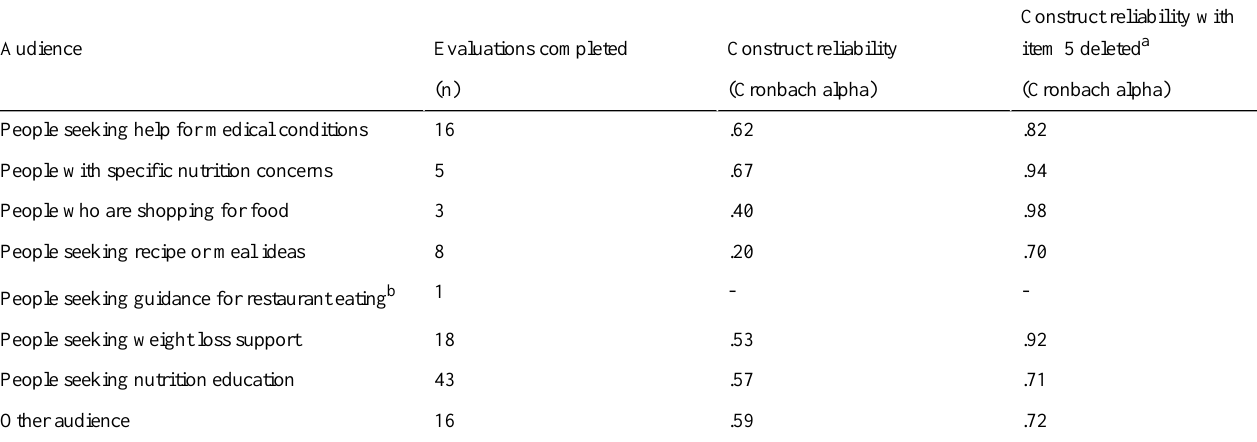
Table 6. Construct reliability of items assessing app appropriateness for evaluator-selected